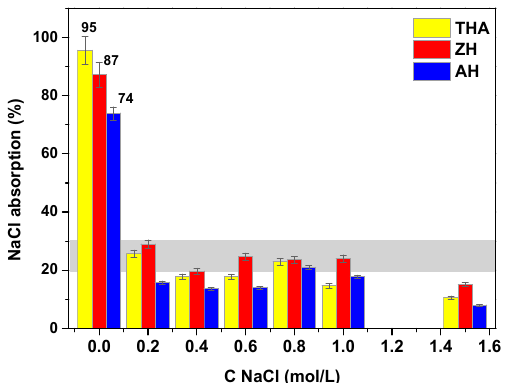
Figure 9. Moisture retention capacity in different concentrations of NaCl solution for THA, ZH and AH.